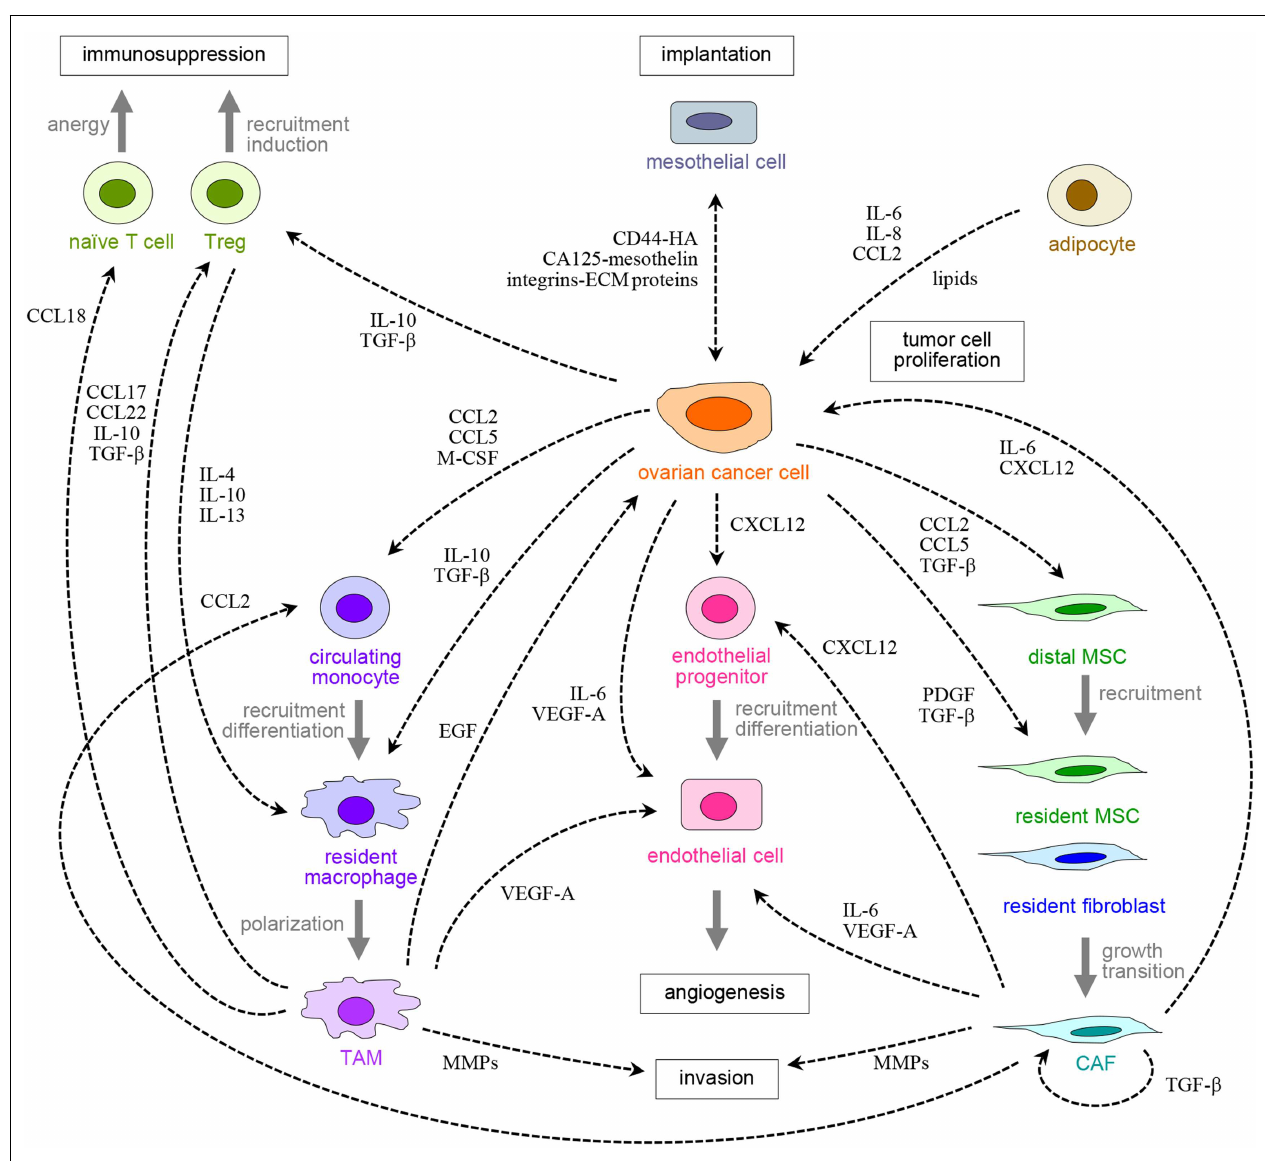
FIGURE 1 | Peritoneal carcinomatosis is orchestrated by cross-talk between ovarian cancer cells, resident peritoneal cells, and other host cells that are recruited to tumors . Examples of receptors and ligands that facilitate these reciprocal cellular interactions are shown.